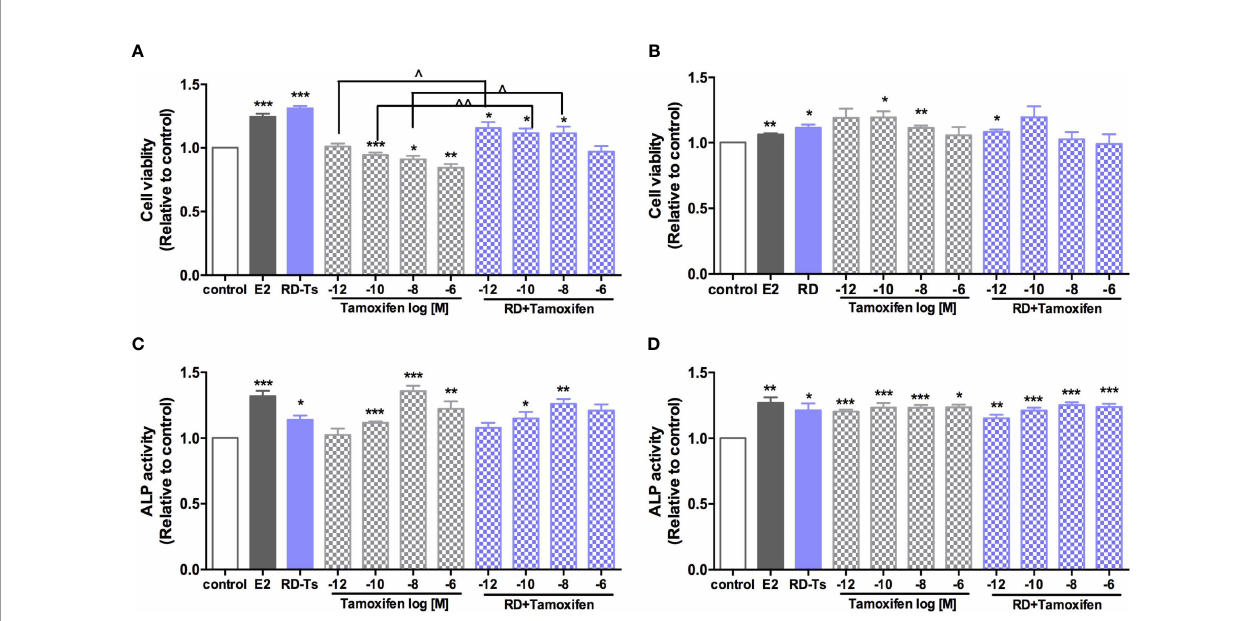
FIGURE 7 | Direct estrogenic effects of RD-treated serum, tamoxifen, and their combinations in ER-positive cells. Human breast cancer MCF-7 (A) , neuroblastoma SHSY5Y (B) , endometrial cancer Ishikawa (C) , and osteosarcoma MG-63 cells (D) were treated with E2 (10 nM), tamoxifen (10 − 12 – 10 − 6 M) or RD-treated serum (10 − 3 dilution) for 48 h. MTS assays were performed in MCF-7 and SH-SY5Y cells while ALP activities were measured in MG-63 cells and Ishikawa cells. Results were expressed as ratio to control. n = 3 or more. * p < 0.05, ** p < 0.01, *** p < 0.001 vs. control; ^ p < 0.05, ^^ p < 0.01 vs. tamoxifen alone. p -value for interaction between RD and tamoxifen at 10 − 12 , 10 − 10 , 10 − 8 , and 10 − 6 M of two-way ANOVA: 0.0045, 0.0089, 0.0728, and 0.0028 for cell viability in MCF-7 cell; 0.0141, 0.2393, 0.0068, and 0.0816 for cell viability in SH-SY5Y cell; 0.2598, 0.1249, 0.0059, and 0.1098 for ALP activity in Ishikawa cell; and 0.1080, 0.258, 0.0222, and 0.5987 for ALP activity in MG-63